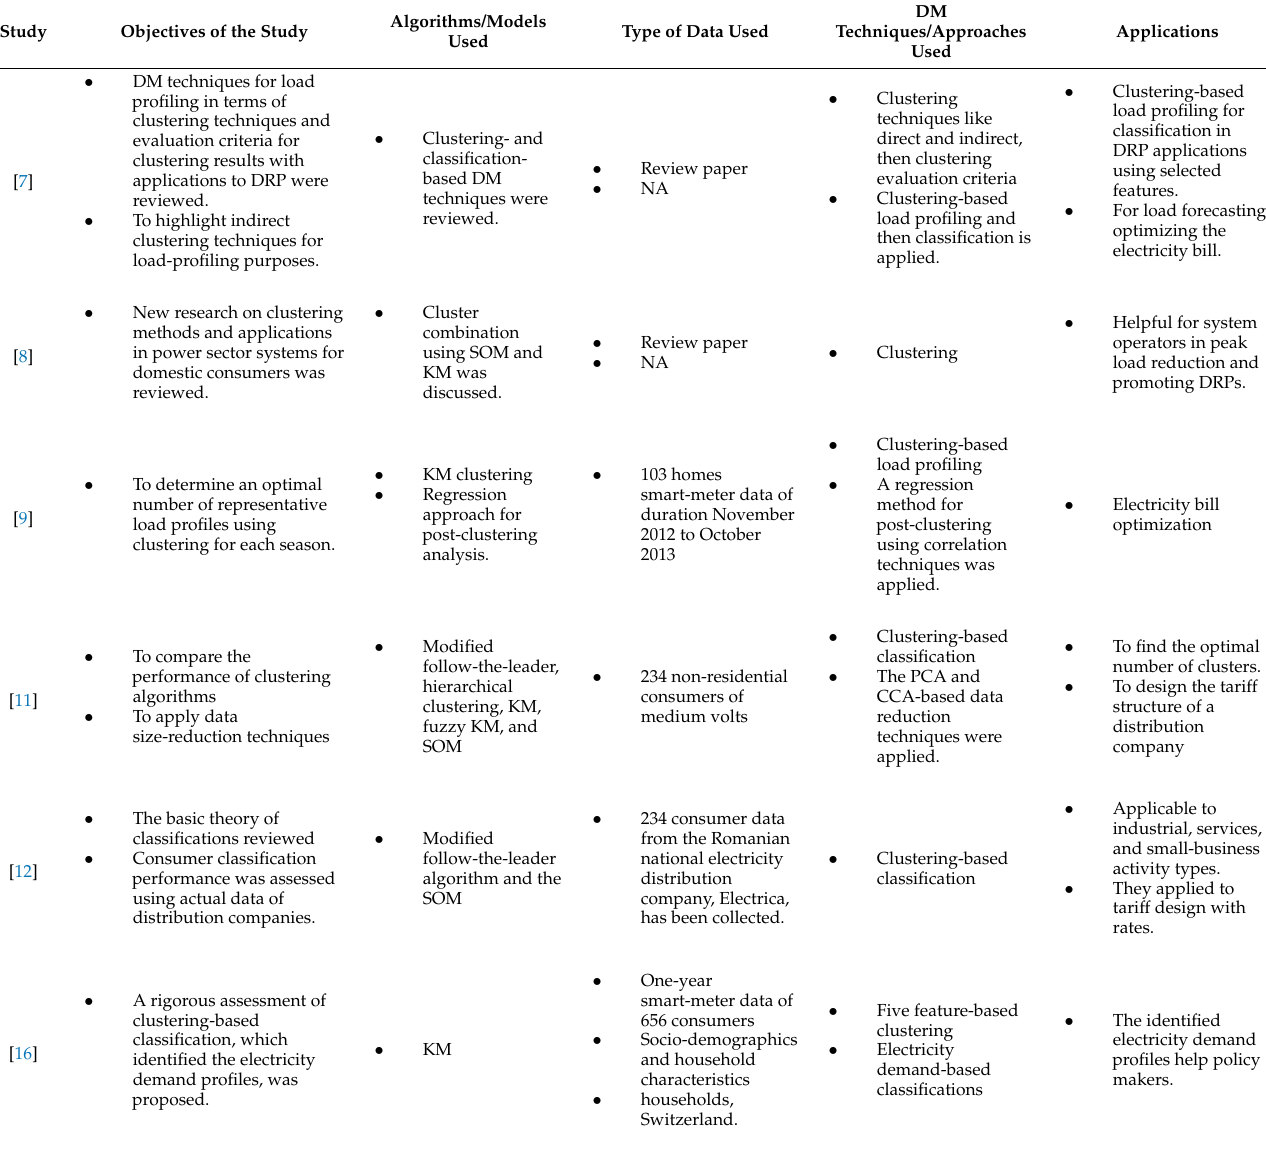
Table 2. HEC-based comparative study of previous work done using DM